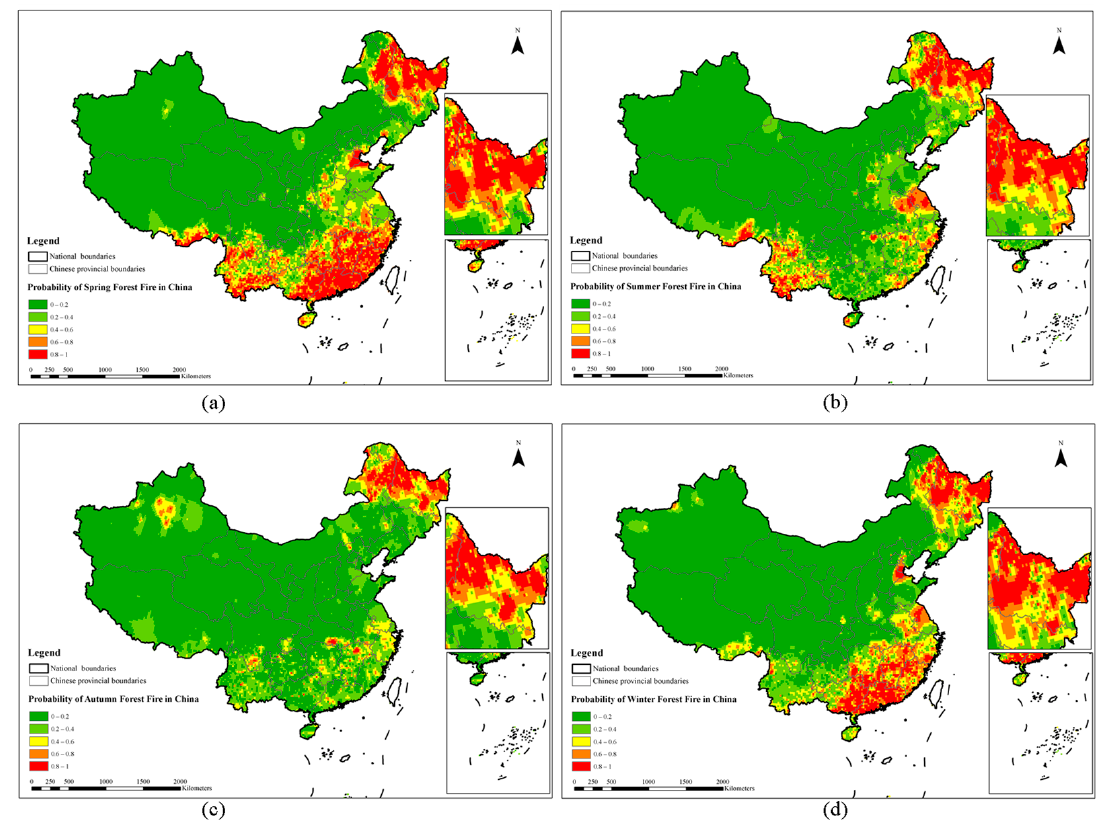
Figure 12. Forest fire probability map for China based on the RF model.